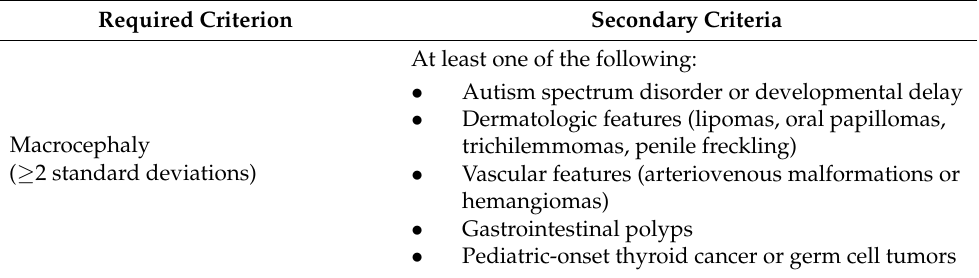
Table with inspiration from Yehia, Keel, Eng 2020, Annual Review of